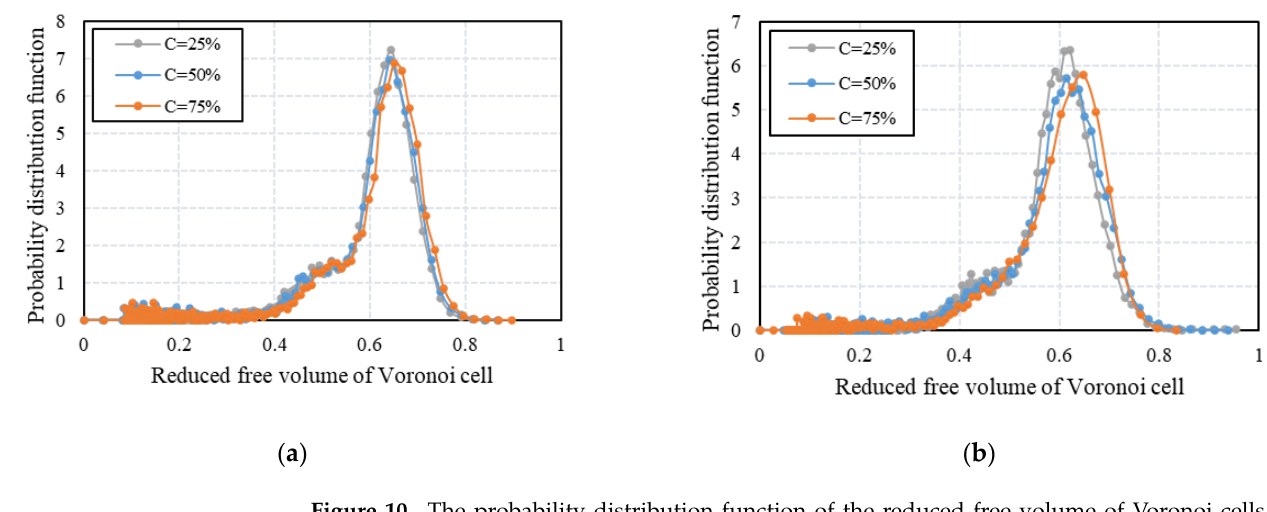
Figure 10. The probability distribution function of the reduced free volume of Voronoi cells of ( a ) binary mixtures AR = 1 and AR = 2, ( b ) binary mixtures AR = 1 and AR = 3.